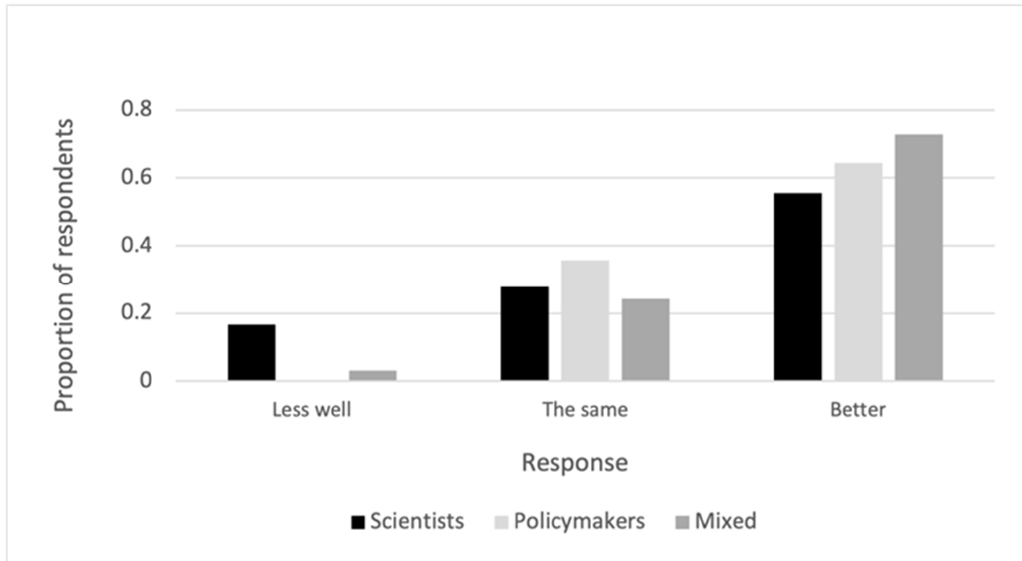
Figure 2. Distribution of responses given by scientists, policymakers, and mixed respondents to the question, “how well is (the best available) mechanism bridging the gap between policy and science?”.